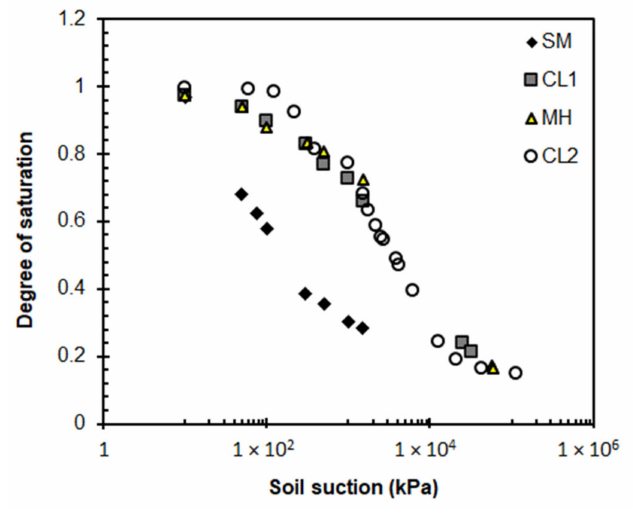
Figure 6. Soil-water characteristic curve data for the four soil types found at the field sites.